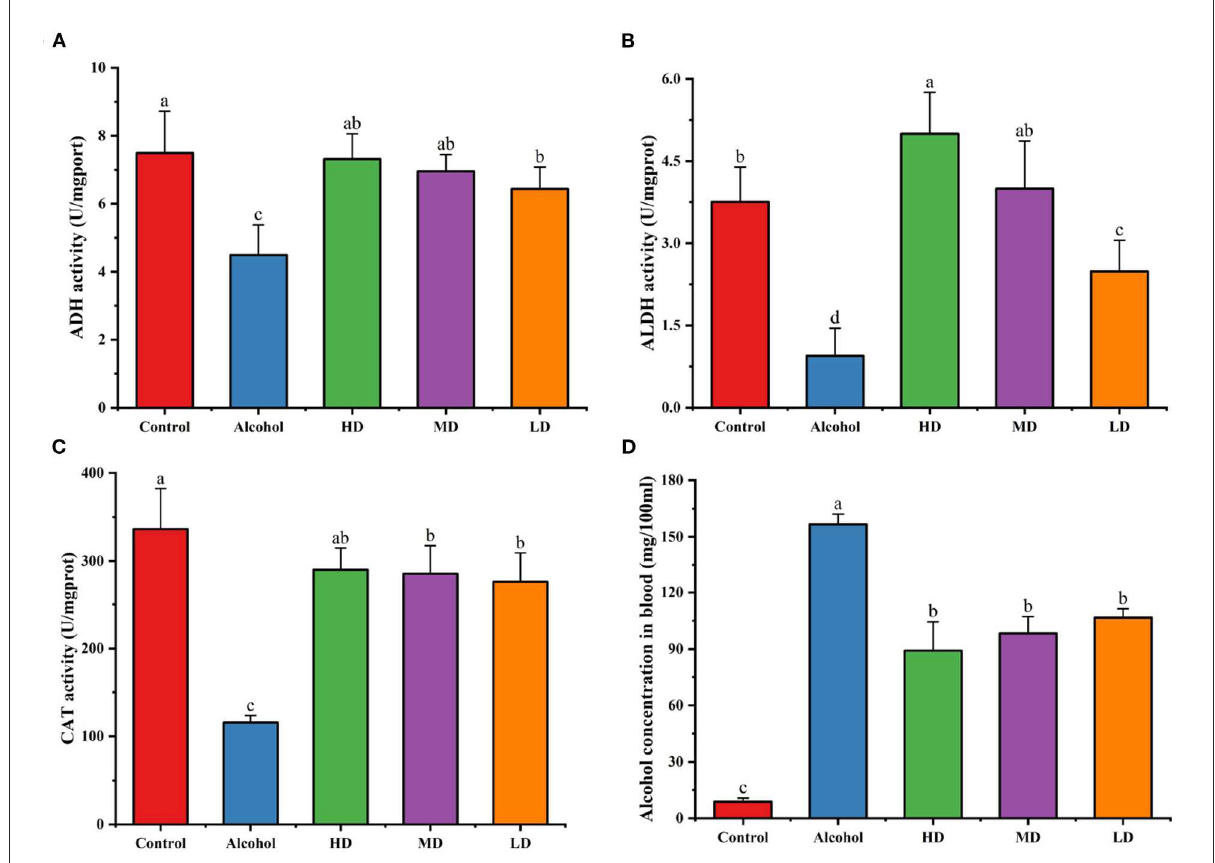
FIGURE5 Effects of lotus root extract on hepatic ADH (A) , ALDH (B) , CAT (C) activities, and serum alcohol content in mice after gavage of alcohol (D) . Different letters represent significant differences between groups (N = 10, p < 0.05).